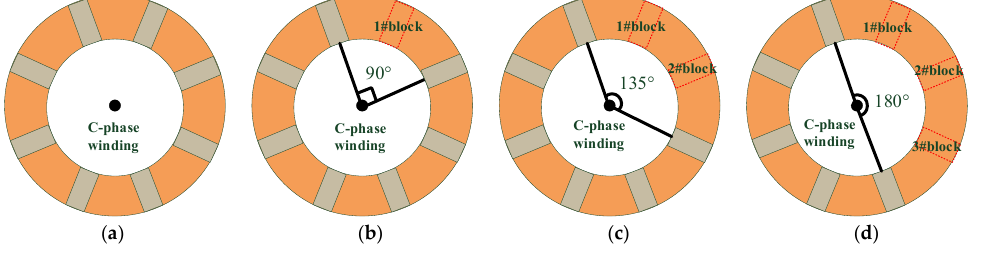
Figure 10. Schematic diagram of corresponding relationship between pad falling and loosening range. ( a ) Rated compression. ( b ) One piece falls off 90°. ( c ) Two pieces fall off 135°. ( d ) Three pieces fall off 180°.